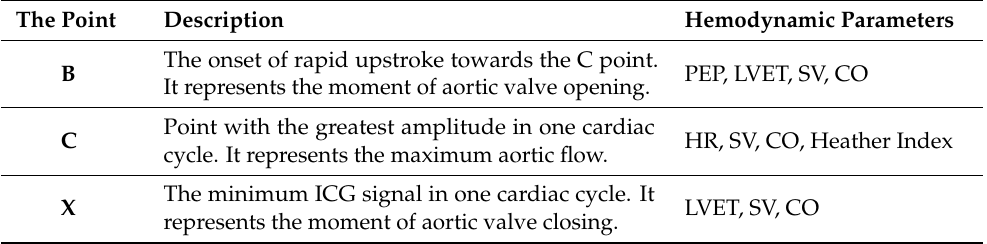
Table 1. A brief overview of the characteristic points of the ICG signal. The last column represents the hemodynamic parameters (described in more detail in Table 2), the values of which are influenced by their positions in the impedance